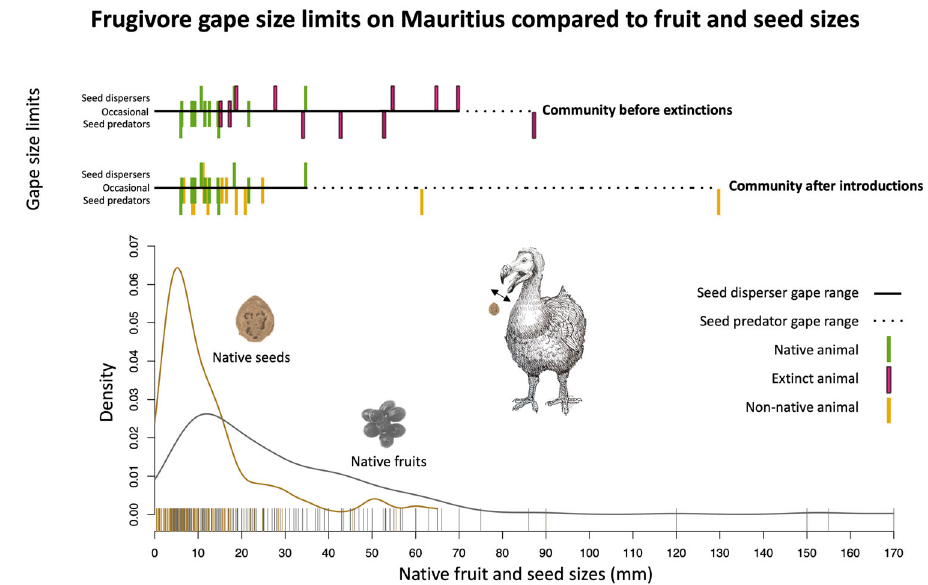
Fig. 2 | Frugivore gape size limits on Mauritius compared to native fruit and seed sizes. The extinction of large frugivores on Mauritius has led to a reduced gape size limitation for seed dispersers and at the same time, the introduction of non-native frugivores had led to an increased gape size for seed predators